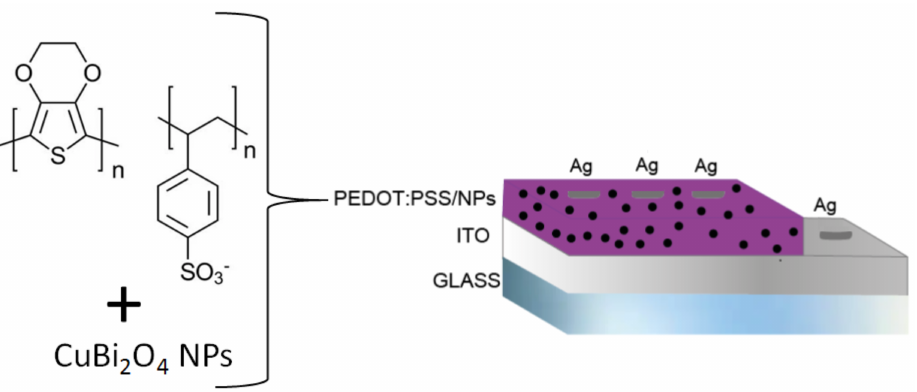
Figure 1. Device structure made of glass/ITO/PEDOT:PSS-CuBi 2 O 4